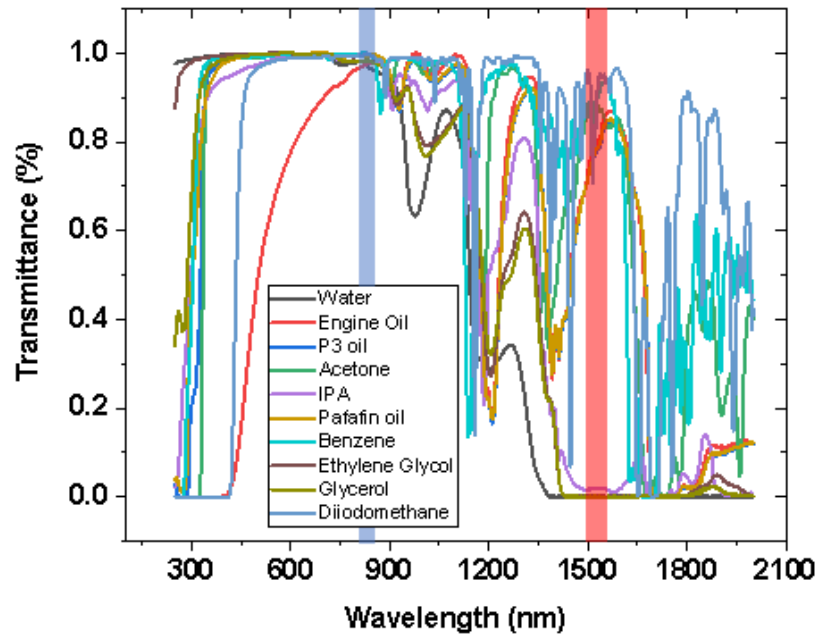
Figure 4. Spectroscopical analysis of the liquids present in Tables 1 and 2. The blue highlighted section is where liquids absorb less radiation, whereas the section highlighted in red shows liquids absorbing within the wavelength range selected by the interrogator.